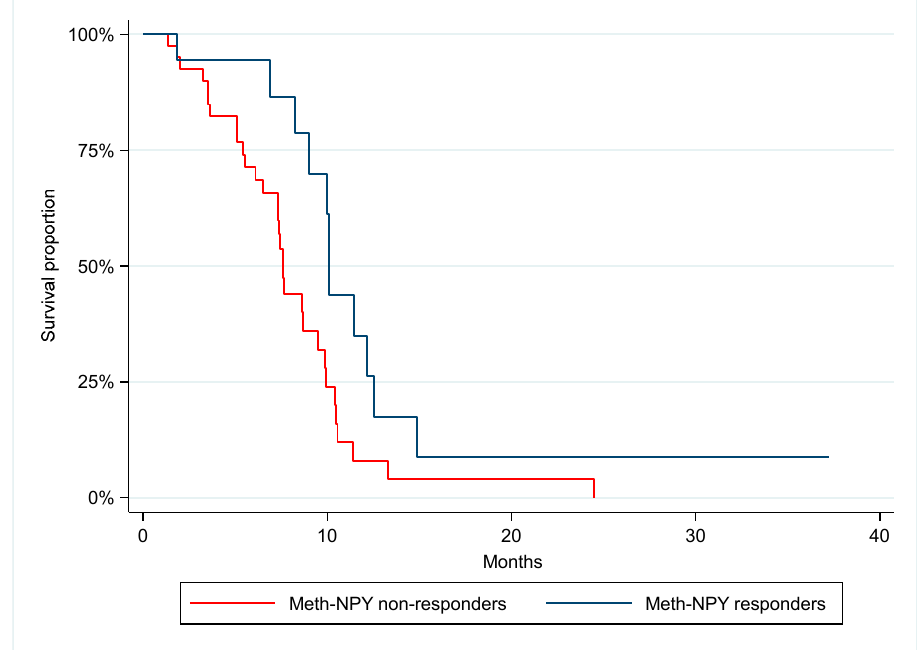
Figure 2. Progression-free survival according to meth-NPY response rate after the first treatment cycle. Median PFS was 10.1 vs. 7.6 months, p= 0.02, HR = 0.43.